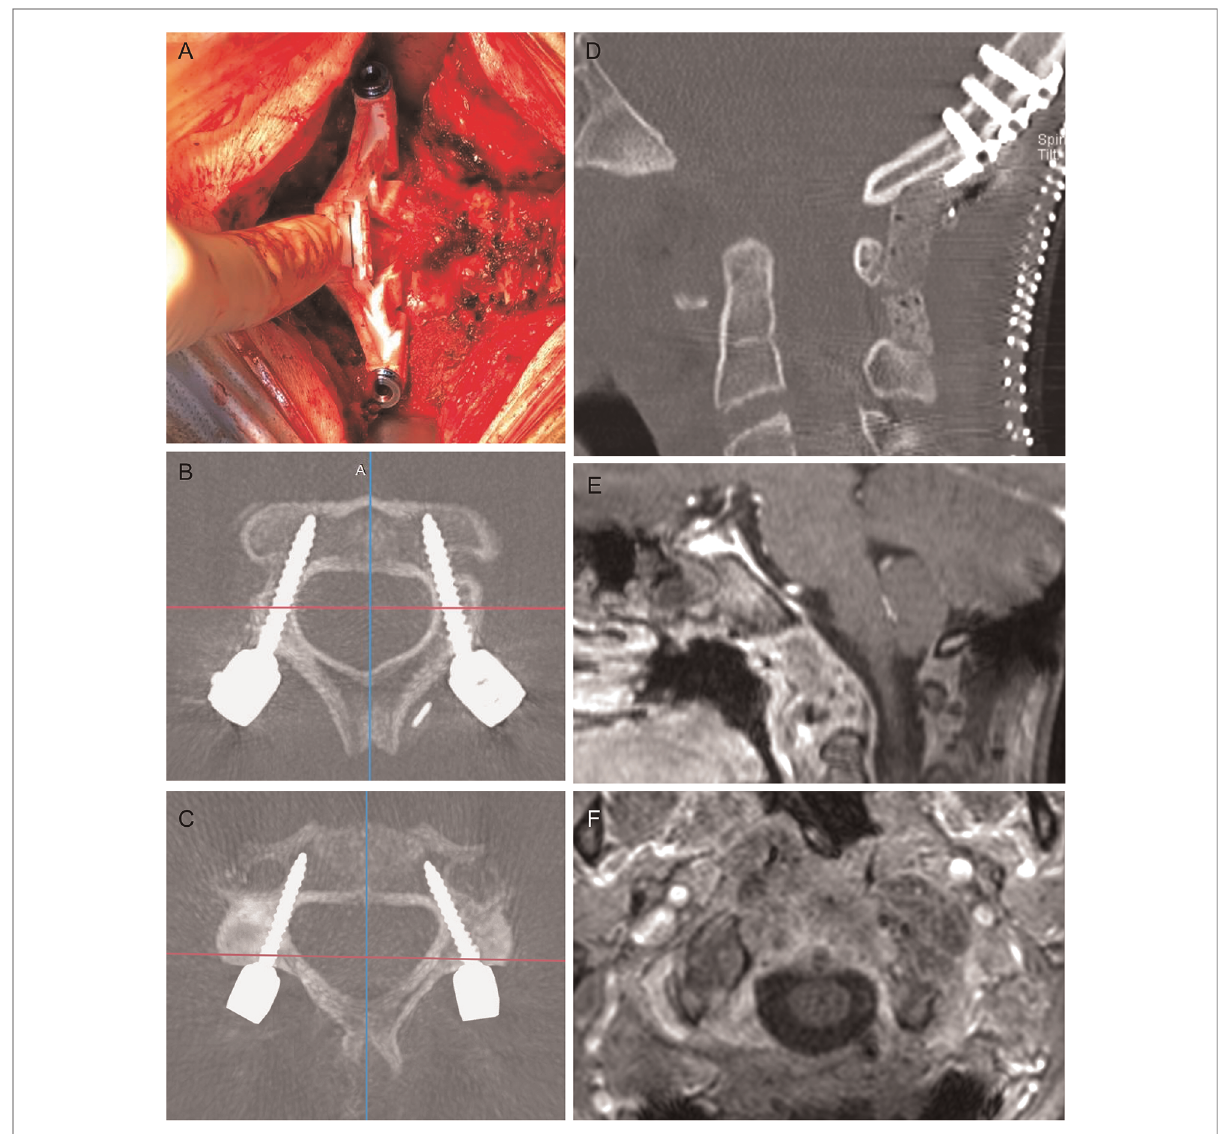
FIGURE 3 Intraoperative view of the printed guide fi tting on C3 lamina ( A ) and postoperative results. Transversal CT scan of screws ’ trajectories in C2 and C3, respectively ( B , C ). The result of anterior decompression was shown in ( D ) and an occipital plate and bicortical screws connected with precontoured rods completed the occipitocervical constructs. One month brain and spine MRI ( E , F ) con fi rms the decompression of the cervicomedullary junction and the optimal extent of